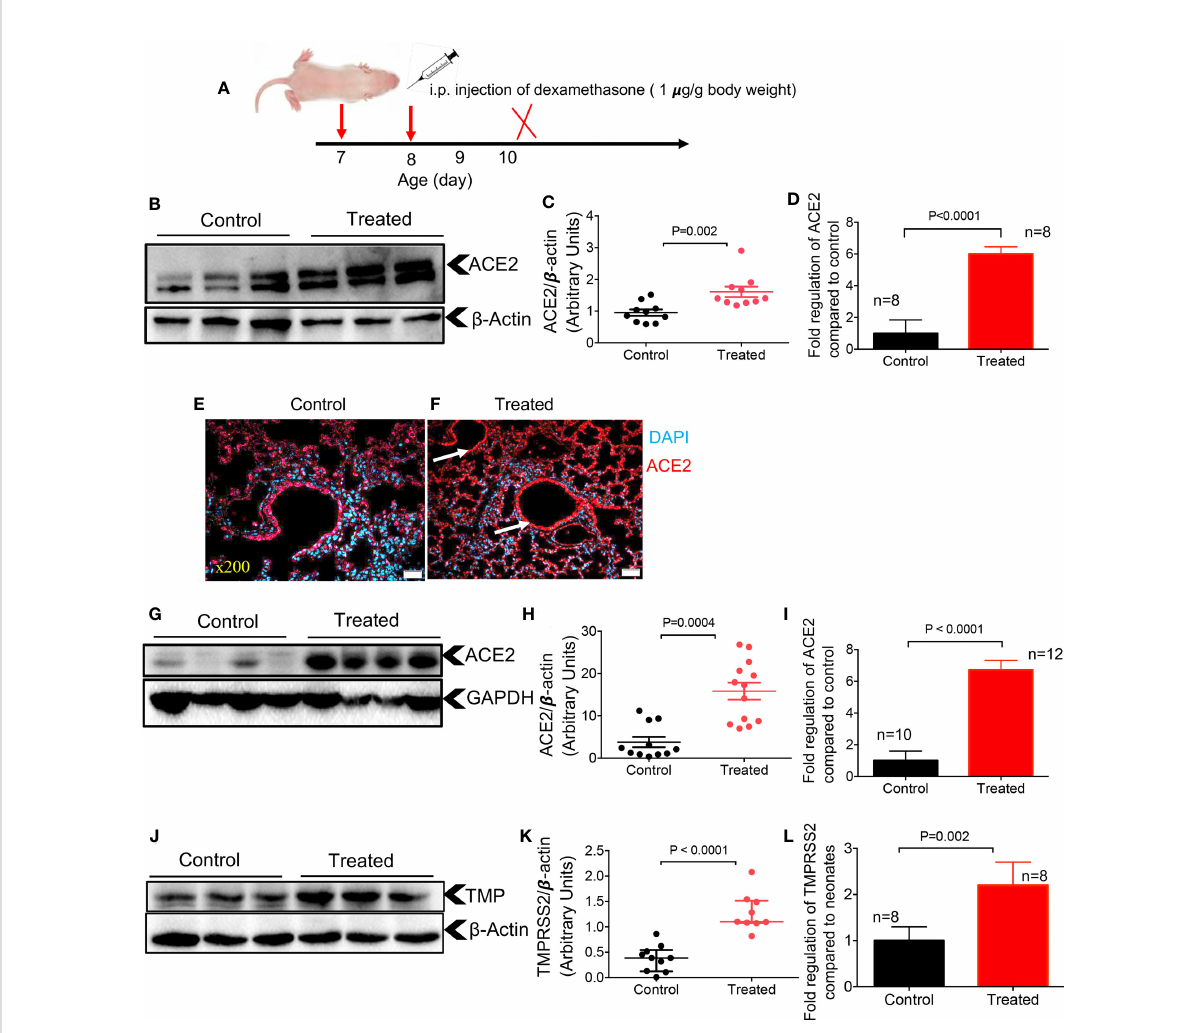
FIGURE 4 Dexamethasone upregulates the expression of ACE2 and TMPRSS2 in the tissues of neonatal mice. (A) Dexamethasone treatment strategy. (B) Representative western immunoblots, and (C) cumulative data of ACE2 protein in the lung tissues of neonatal mice treated with dexamethasone (IP, 1 m g/g body weight for two consecutive days) versus those treated with PBS (control). (D) Cumulative data showing fold regulation of ACE2 mRNA in the lung tissues of treated neonates versus control. (E) Representative immuno fl uorescence (IF) images of ACE2 expression in the lung tissue of a control versus (F) dexamethasone treated neonatal mouse (5 sections/tissue, n= >3/group). Scale bar: 100 m m. Magni fi cation x200. (G) Representative western immunoblots, and (H) cumulative data of ACE2 protein in the heart tissues of control versus dexamethasone treated neonatal mice (I) Cumulative data showing fold regulation of ACE2 mRNA in the heart tissues of neonatal mice treated with dexamethasone compared to controls. (J) Representative western immunoblots, and (K) cumulative data of TMPRSS2 (TMP) protein in the lung tissues of control versus dexamethasone treated neonatal mice (L) Cumulative data showing fold regulation of TMPRSS2 mRNA in the lung tissues of neonatal mice treated with dexamethasone compared to controls. All blots were repeated for reproducibility and lanes were loaded with equal amounts of protein. Quanti fi cation of ACE2 and TMPRSS2 normalised to the loading control. Error bars indicate mean ± SEM from more than three independent